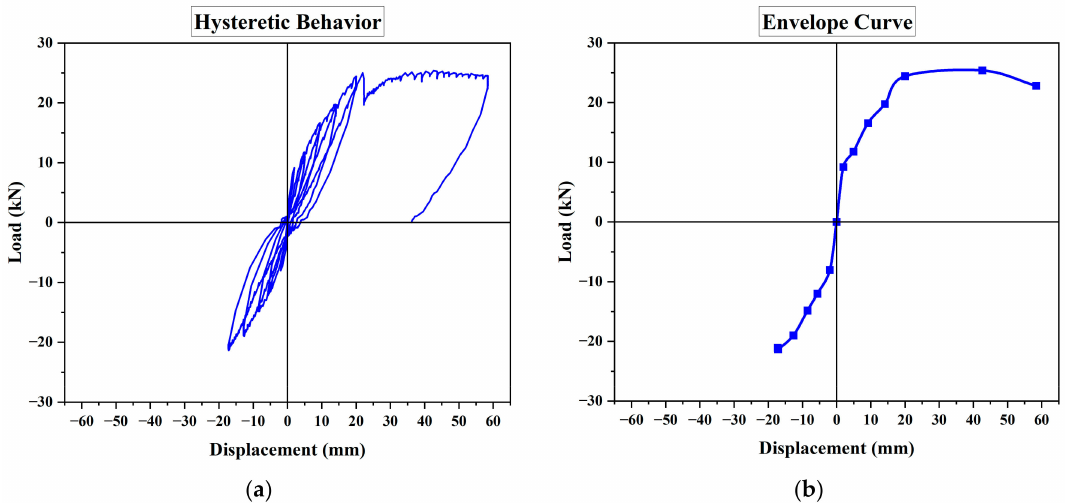
Figure 6. Experimental results of OPC-BF ( a ) Hysteretic response ( b ) Envelope